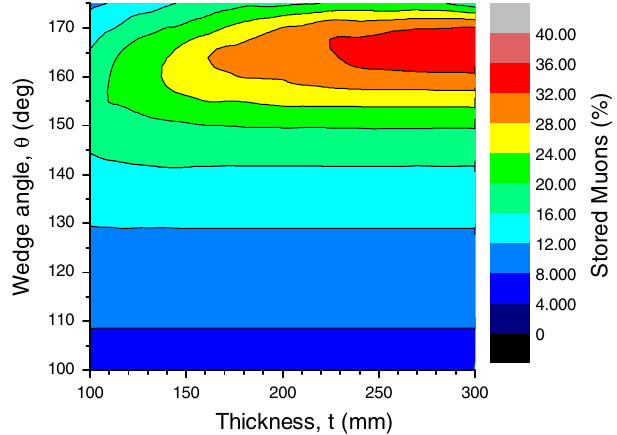
FIG. 5. Color map showing the improvement in performance as a function of thickness and angle of the wedge. We assume a ð C Þ 2 H 4 n house-shaped wedge and as thickness we define the maximum distance along the beam direction. The vertical scale on the right shows the percentage of gained or lost stored muons compared to the no absorber case. The number of stored muons is increased by more than 30% when the wedge thickness is > 220 mm and its angle is between 160º and 170º. The wedge is pointing along the horizontal direction with its apex placed near the beam center so that it covers at least half of the beam, mainly the high-momentum particles.